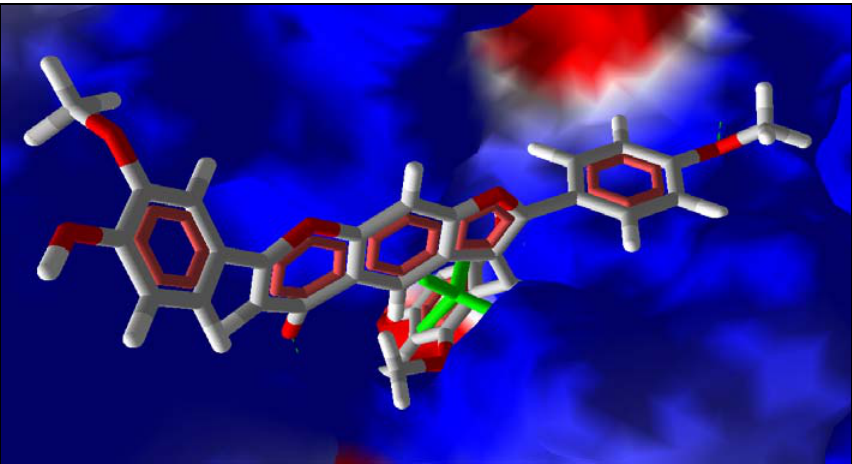
Figure 9. Electrostatic surface of TIM showing the insertion of a substituted phenyl ring of cissampeloflavone (red and white) into the HPO4 2- (green) binding